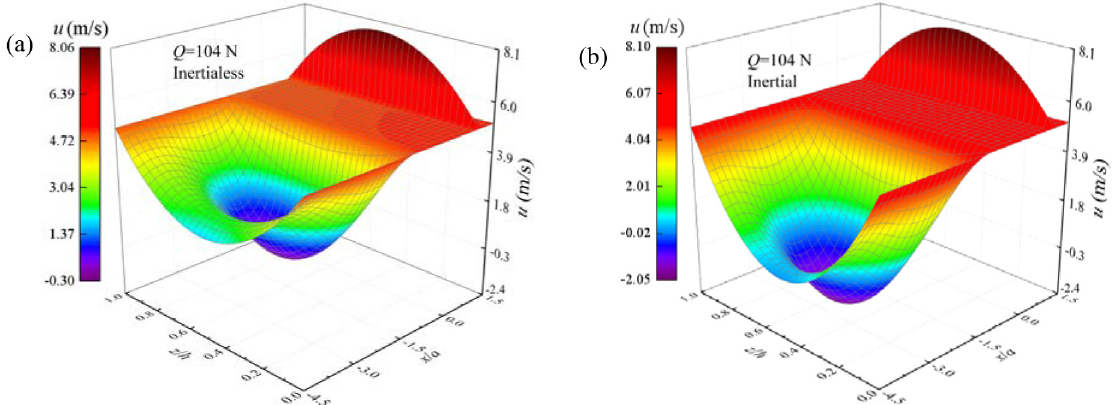
Fig. 8. Fluid velocity on plane y =0: (a) without inertial effect, and (b) with inertial effect.